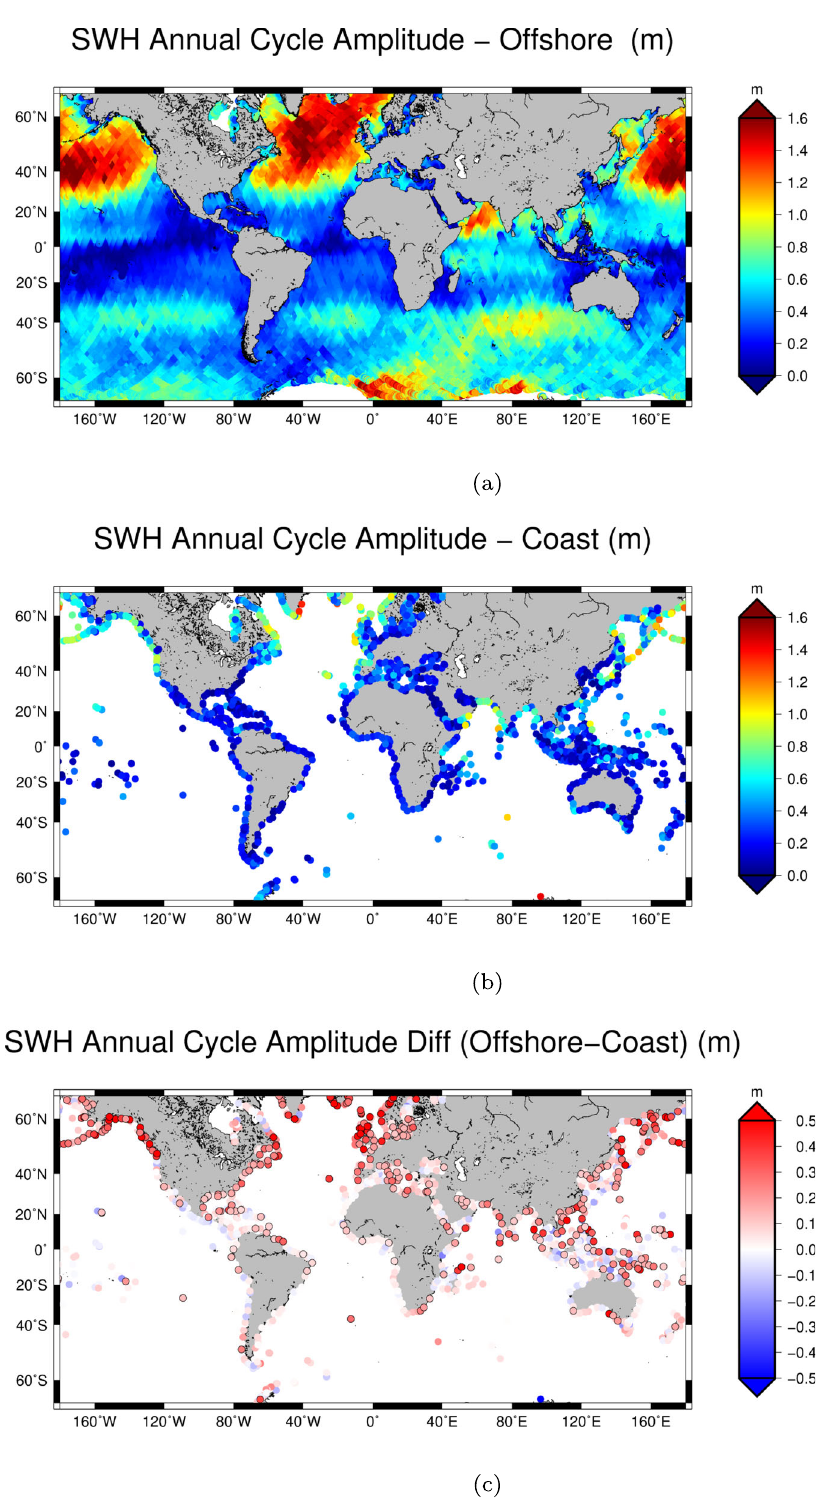
Fig. 3 Amplitude of the annual cycle. Amplitude of the annual cycle computed for signi fi cant wave height (SWH) time series from along-track satellite altimetry over the global ocean ( a ) and along the coastline ( b ). c shows the difference between the offshore and the coastal estimate of the amplitude. Statistically signi fi cant differences are marked with a black contour. The point is marked as signi fi cant if the absolute value of the difference between the offshore and the coastal amplitude is higher than its uncertainty. Uncertainties are computed as described in section Computation of mean SWH and annual